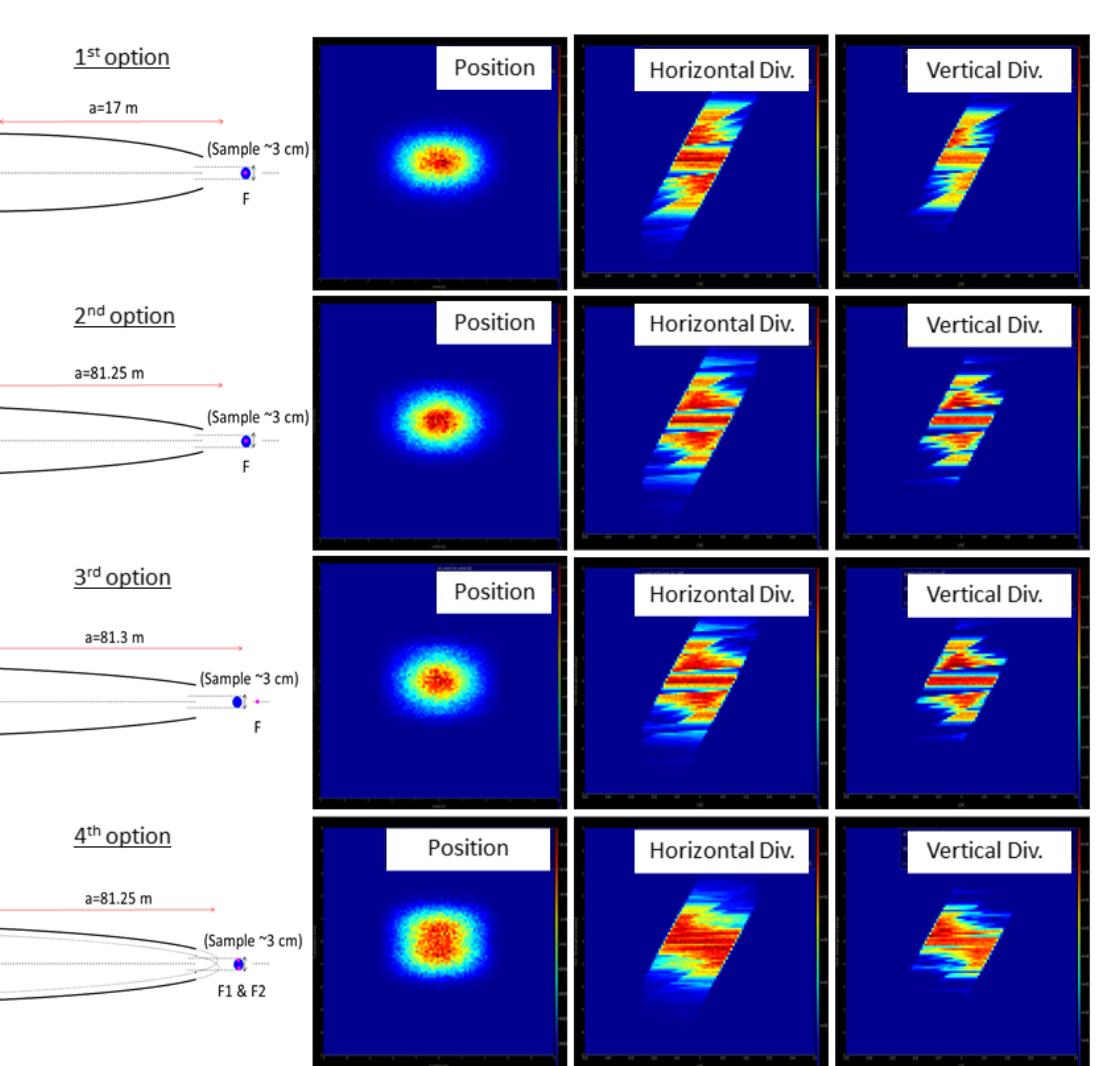
Figure 9. Beamspots and acceptance diagrams (position-divergence plots) for the four focusing guide options described in the text. For all configurations, the range of the divergence axes is ± 5°, the position axes ± 5 cm, and [0, 5]·10 8 n/s and [0, 7]·10 8 n/s for the color scale of the horizontal and vertical diagrams, respectively.